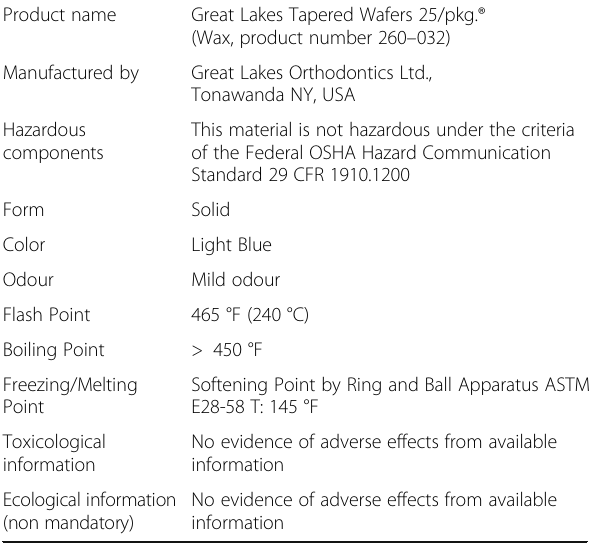
Table 1 Attributes of the Great Lakes Tapered Wafers 25/pkg.®, according to Sections 3, 9, 11, and 12 of the Safety Data Sheet provided by the manufacturer (www.greatlakesortho.com)